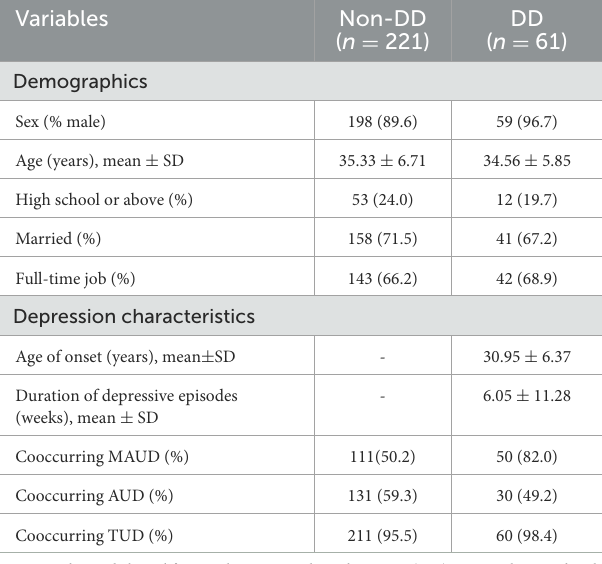
TABLE 1 Description of the analyzed